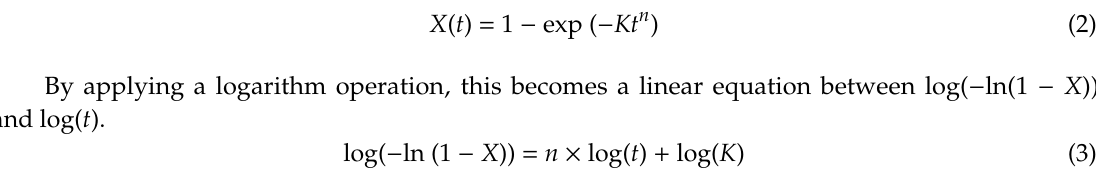
Figure 3. 4140 steel transformation kinetics curves of 4140 steel from 343 ° C to 288 ° C.